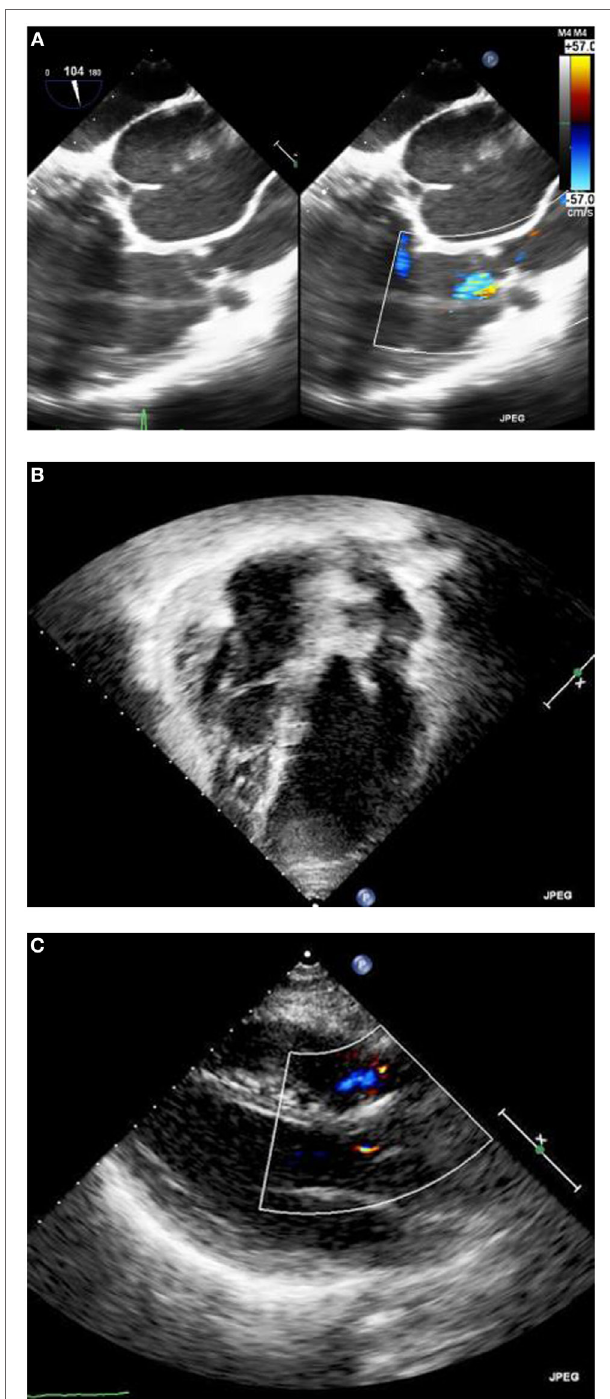
FIGURe 3 | (a) Intra-operative transesophageal echocardiography after repair, showing trivial residual degree of pulmonary valve regurgitation. (B) Pre-discharge trans-thoracic echocardiography with the four chamber views. (C) Pre-discharge trans-thoracic echocardiography with the long-axis view.